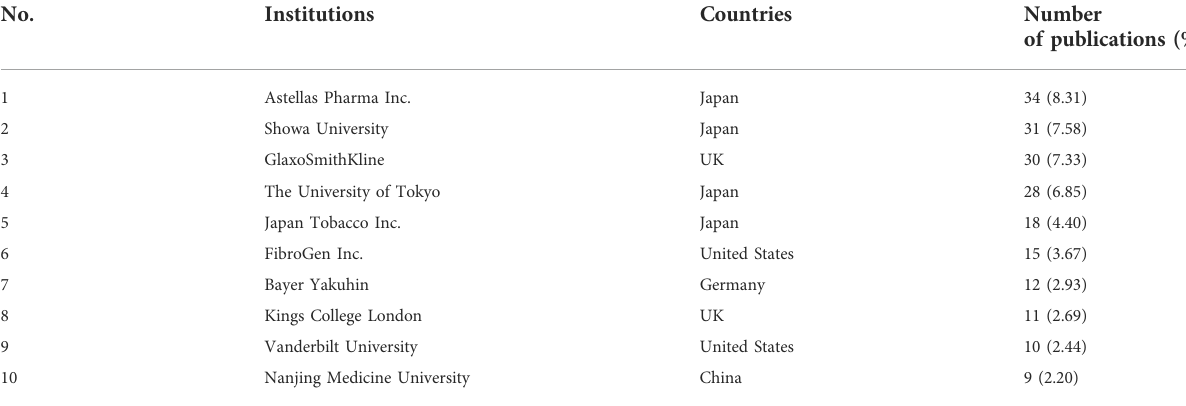
of publications (%)